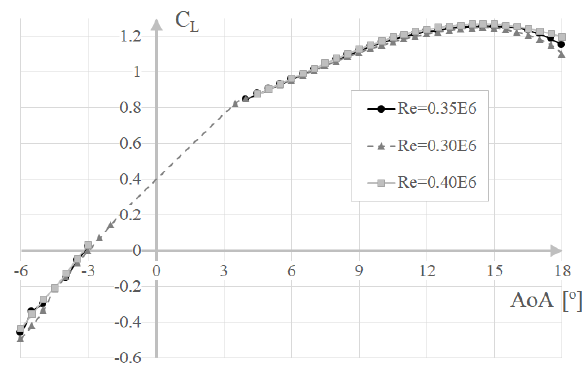
Figure 16. Olissipo Air Team optimized